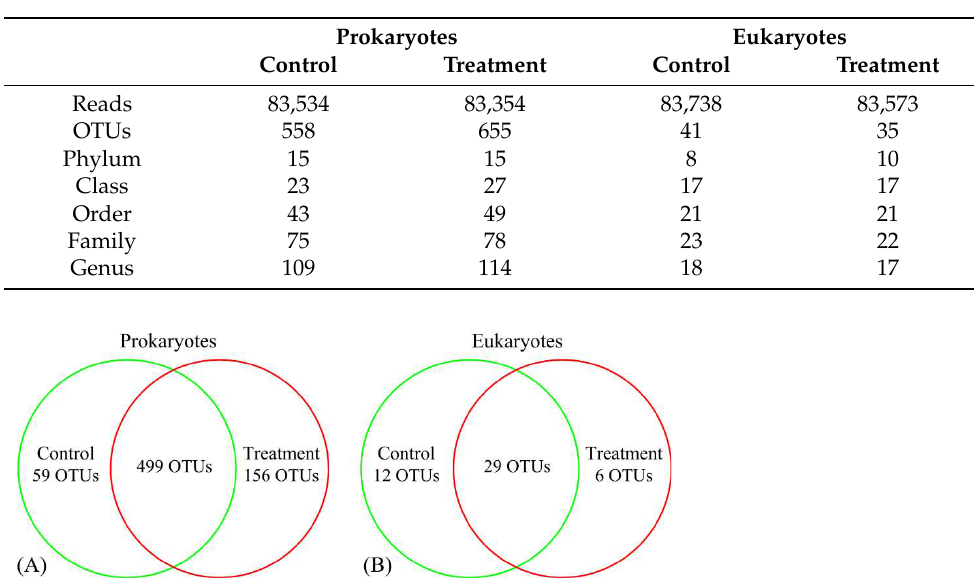
Table 1. Summary of sequencing results at different taxonomical levels of prokaryotic and eukaryotic microbiota in the control and treatment groups.